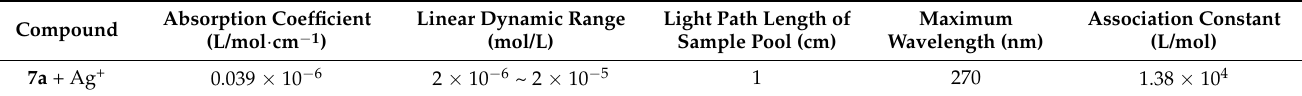
Table 2. The analytical parameters of the UV–Vis spectral titration test and Job’s plot experiment.